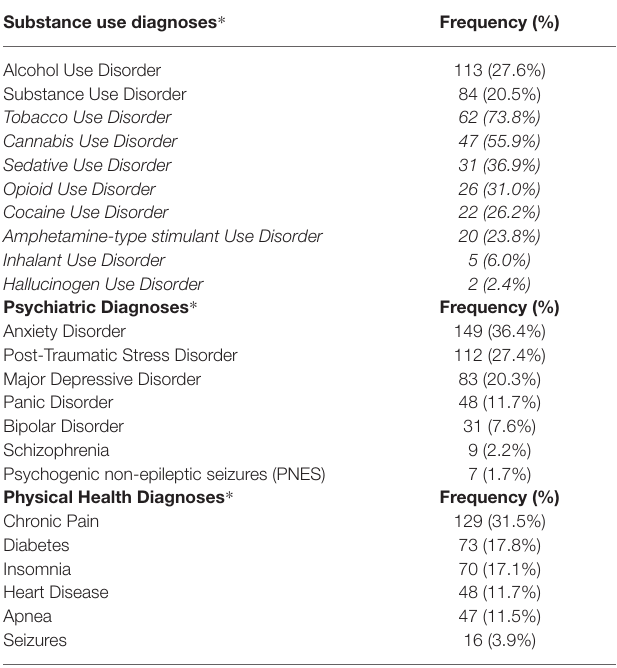
TABLE 2 | Veteran sample substance use, psychiatric, and physical health diagnoses. Substance use diagnoses *